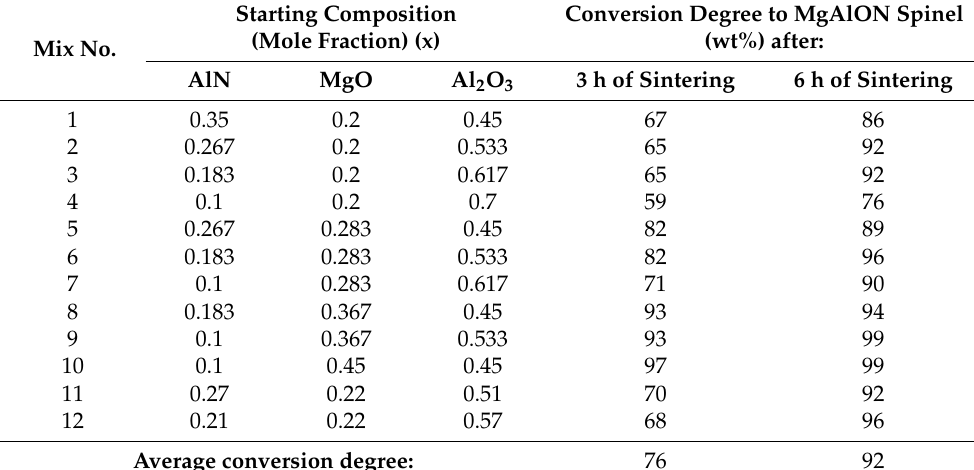
Table 5. Conversion degree (wt% of MgAlON spinel determined using XRD) of powder mixtures to MgAlON spinel depending on their starting composition and holding time. See Supplementary Table S1 for the respective amounts of residue phases Al 2 O 3 , AlN, and MgO after sintering. Starting Composition Conversion Degree to MgAlON Spinel (Mole Fraction) (x) (wt%) after: Mix No. AlN MgO Al 2 O 3 3 h of Sintering 6 h of